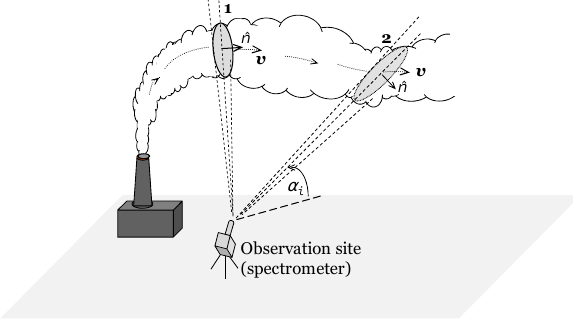
Fig. 1. Flux measurement across two cross-sections of a plume. The dashed lines represent the directions at elevation angle α i along which the telescope is pointing, ˆ n denotes the unit vector orthog- onal to the corresponding cross-section, and v is the wind velocity.